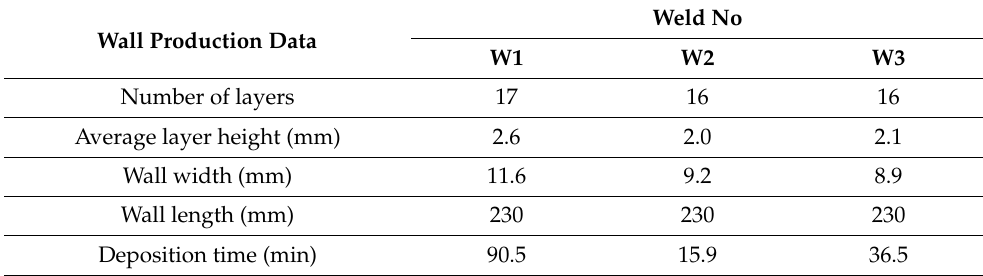
Table 3. Deposition results.